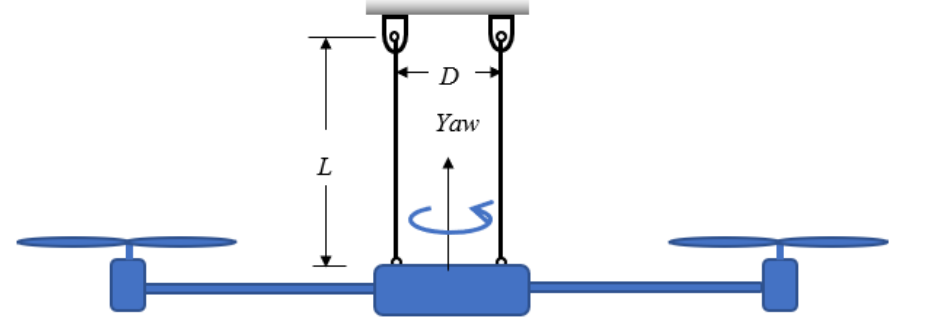
Figure 11. Depiction of a quadcopter bifilar pendulum. Table 5. Moment of inertia of the X500 quadcopter about the yaw axis. Table 5. Moment of inertia of the X500 quadcopter about the yaw axis. Description of